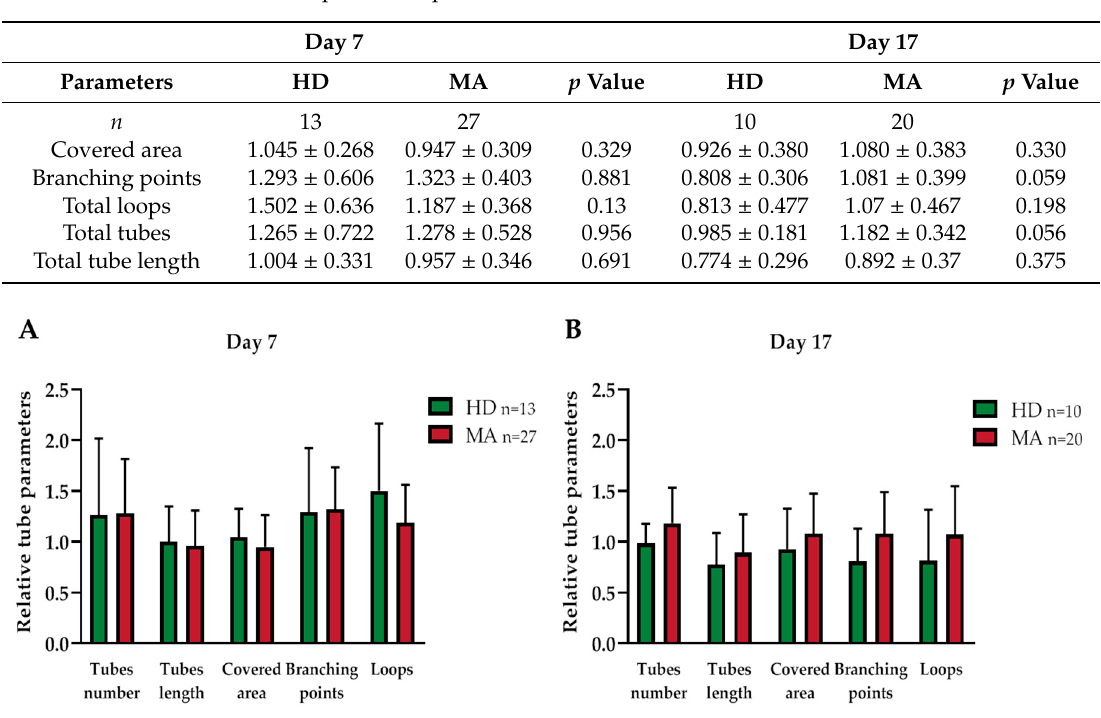
Figure 6. Vasculogenic capacity of HUVEC cells cultured in conditioned media collected ( A ) 7 and ( B ) 17 days after seeding of EPCs from HD and from a heterogeneous group of MA patients (each different tube parameter has been normalized with values obtained by HUVEC cells in EGM-MV medium): Data were expressed as mean ± SD, and statistical significance was calculated through Student’s t -test. Values of at least three independent experiments are shown.